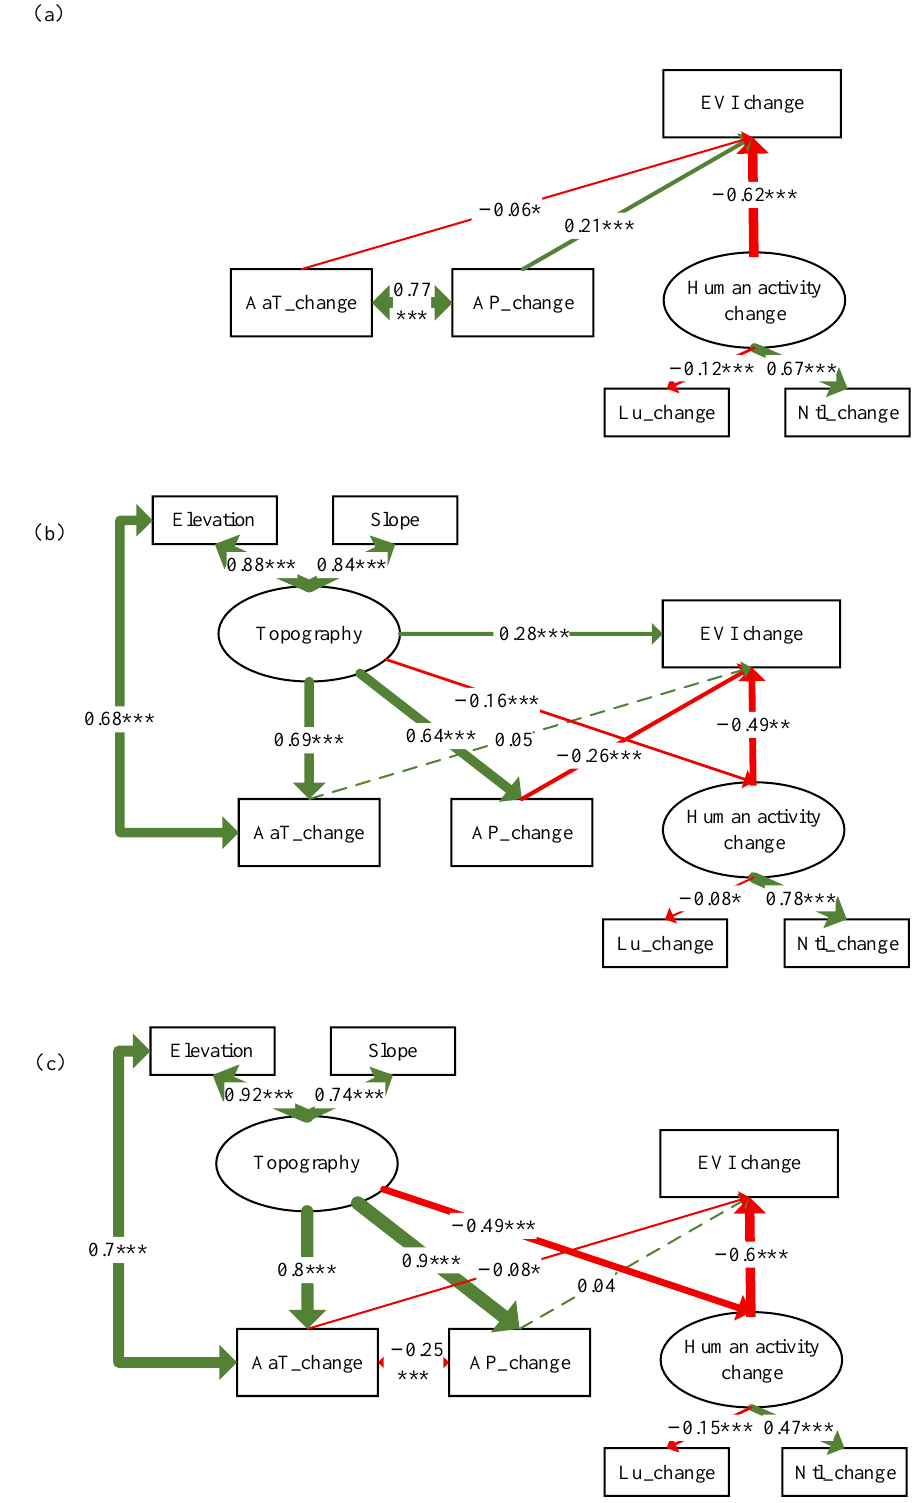
Figure 12. SEM of the relationship between EVI change and its drivers in ( a ) Northern, ( b ) Central and ( c ) Southern Anhui Province. Note: AaT_change = annual average temperature change; AP_change = annual precipitation change; Lu_change = Land use change; Ntl_change = nighttime light change. Green lines represent positive effects; red lines represent negative effects. Solid lines represent significant paths. *** Significant at the 99% level; ** Significant at the 95% level; * Significant at the 90% level.